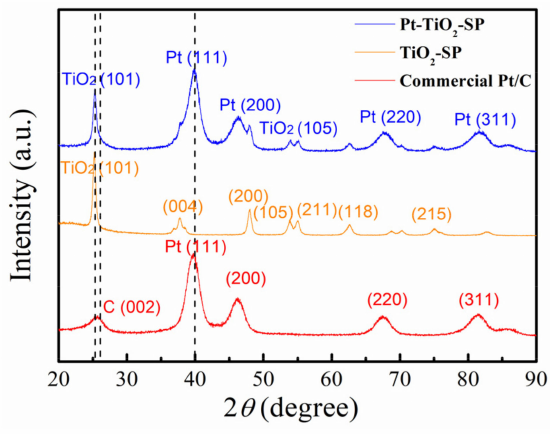
Figure 3. XRD patterns of Pt/C, TiO 2 -SP, Pt-TiO 2